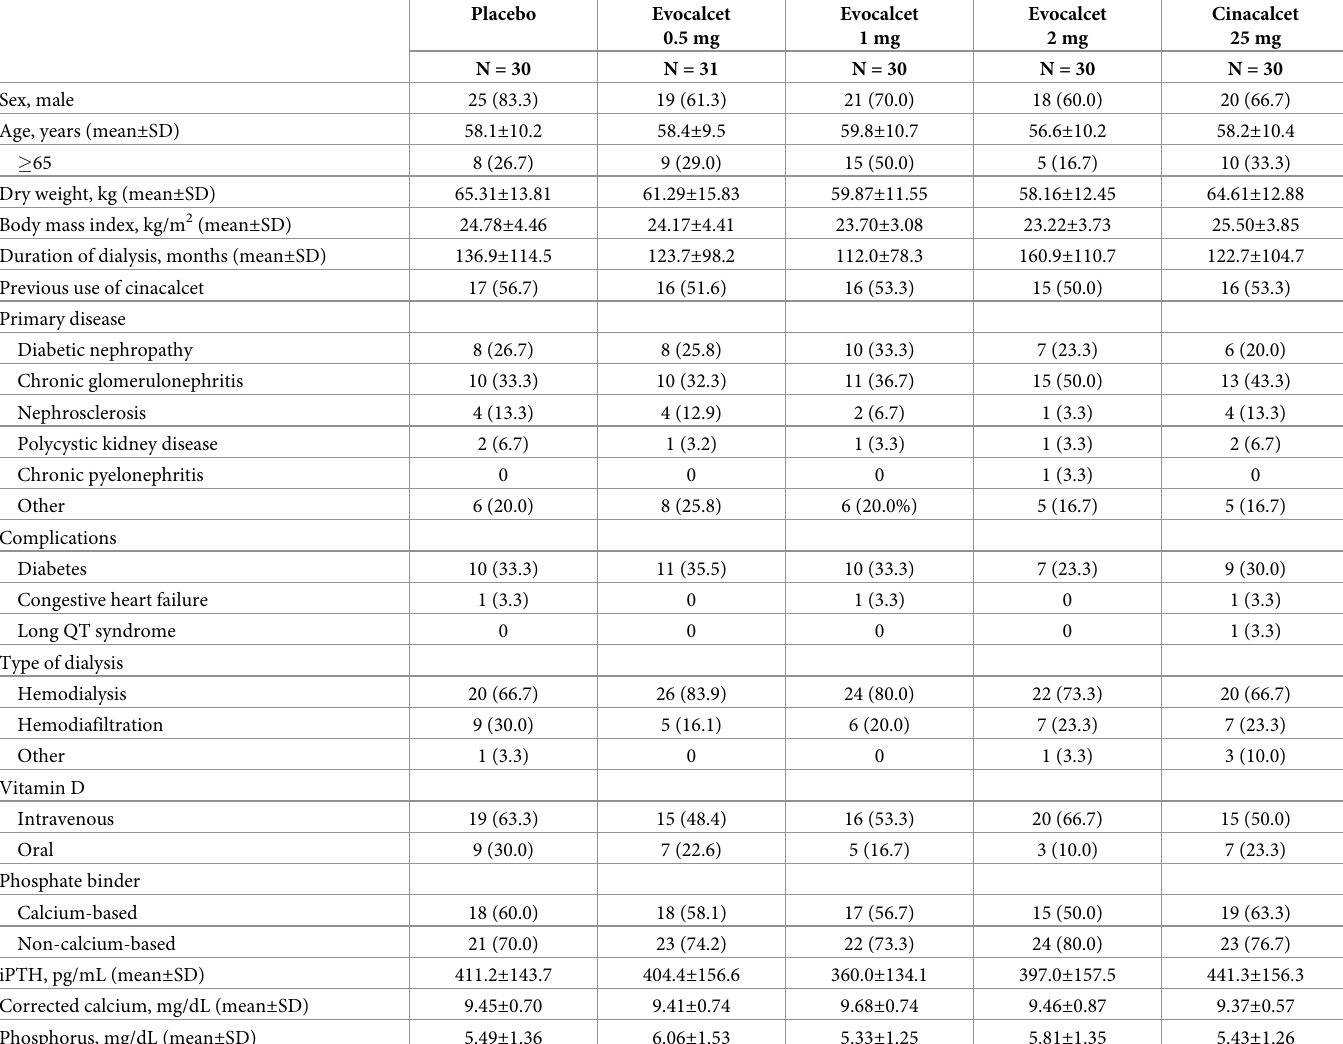
Table 1. Baseline demographic and clinical characteristics of patients in the five groups (Safety analysis